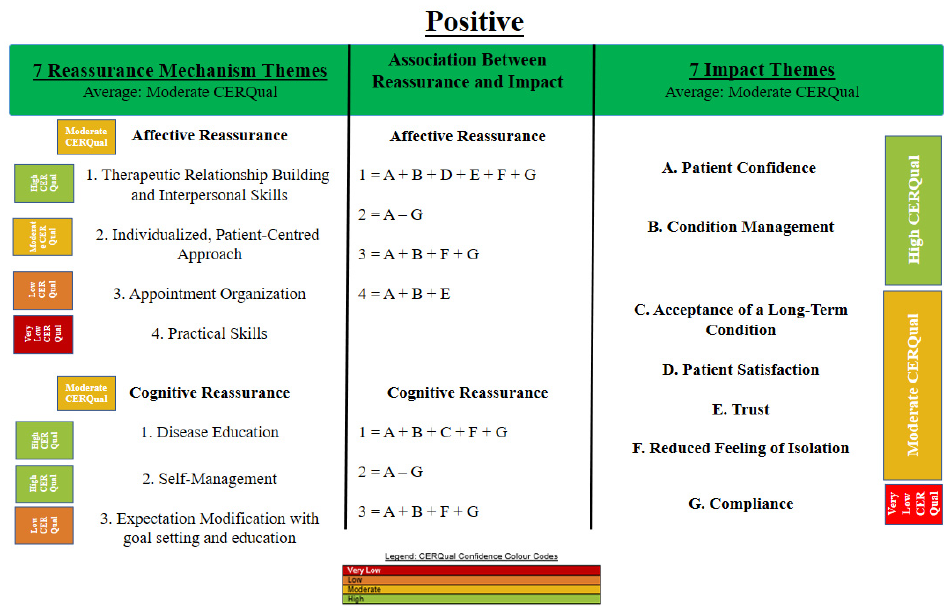
Figure 2. CERQual summary of thematic findings displaying the positive impact of reassurance and mechanisms. Note: View this figure from left to right. The left of the figure identifies mechanisms within interactions. The association between mechanism and impact is illustrated at the center of the figure and identifies how mechanism relate to multiple outcomes identified on the right of the figure.